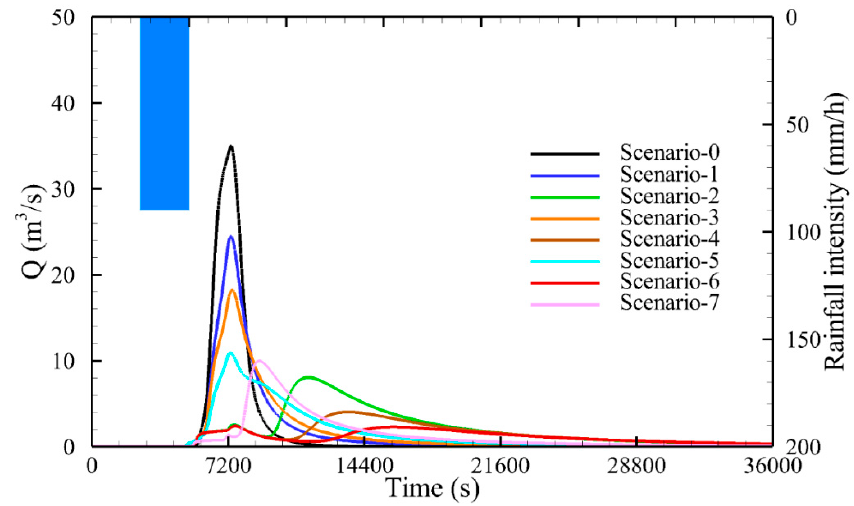
Figure 5. Hydrographs at the catchment outlet under different scenarios (Q: discharge).